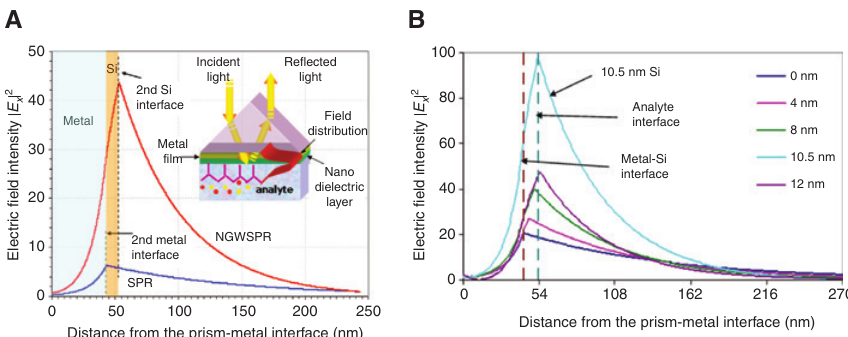
Figure 7: Field intensity distribution for the case of having a nanolayer with high refractive index on top of the metal film. (A) Geometry of the structure and field distribution for the case of λ = 653 nm, n = 10 nm. (B) Field intensity distribution at different Si layer thicknesses for the case λ = 633 nm, d d Si _ film = 1.33.Reproduced with permission (A) from [55] and (B) from [52]. n a